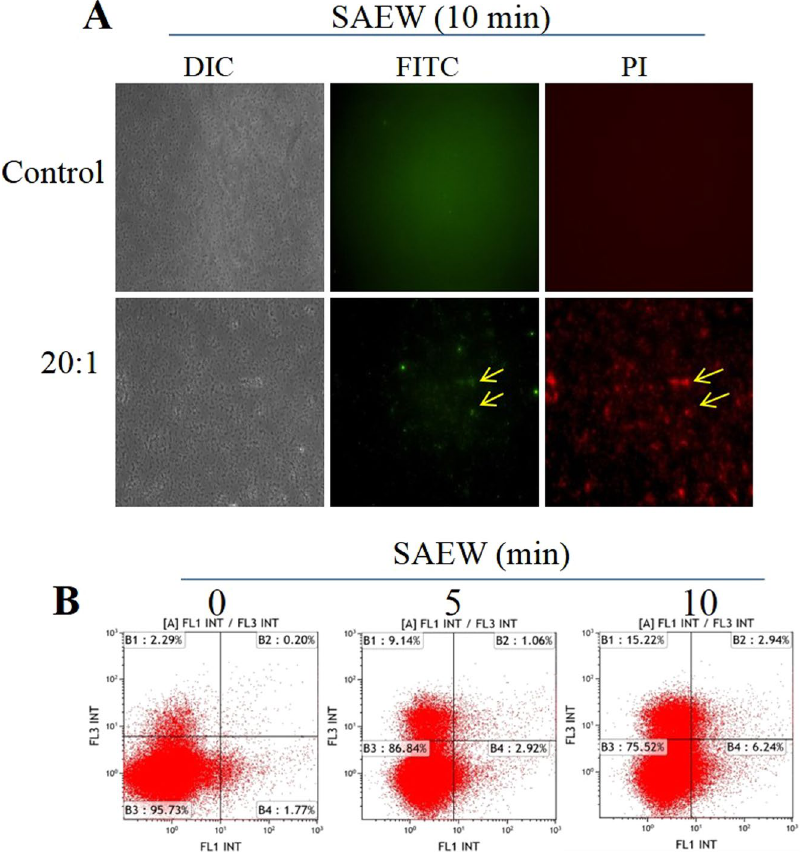
Figure 6. SAEW induced E. coli necrosis and apoptosis, as measured with fluorescence microscopy and flow cytometry. ( A ) The representative data of the FITC-PI label were observed with a fluorescence microscope and (B ) flow